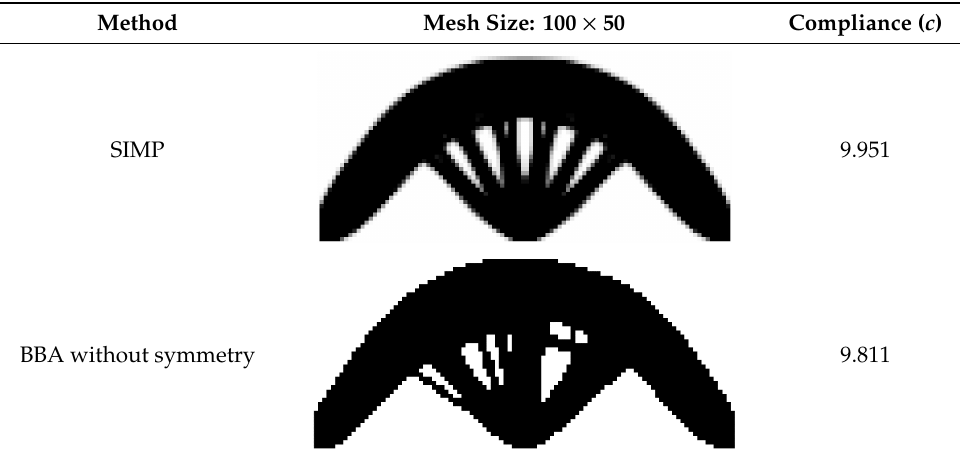
Figure 6. Problem definition of the pinned-pinned plate: design domain, loading, and supports.